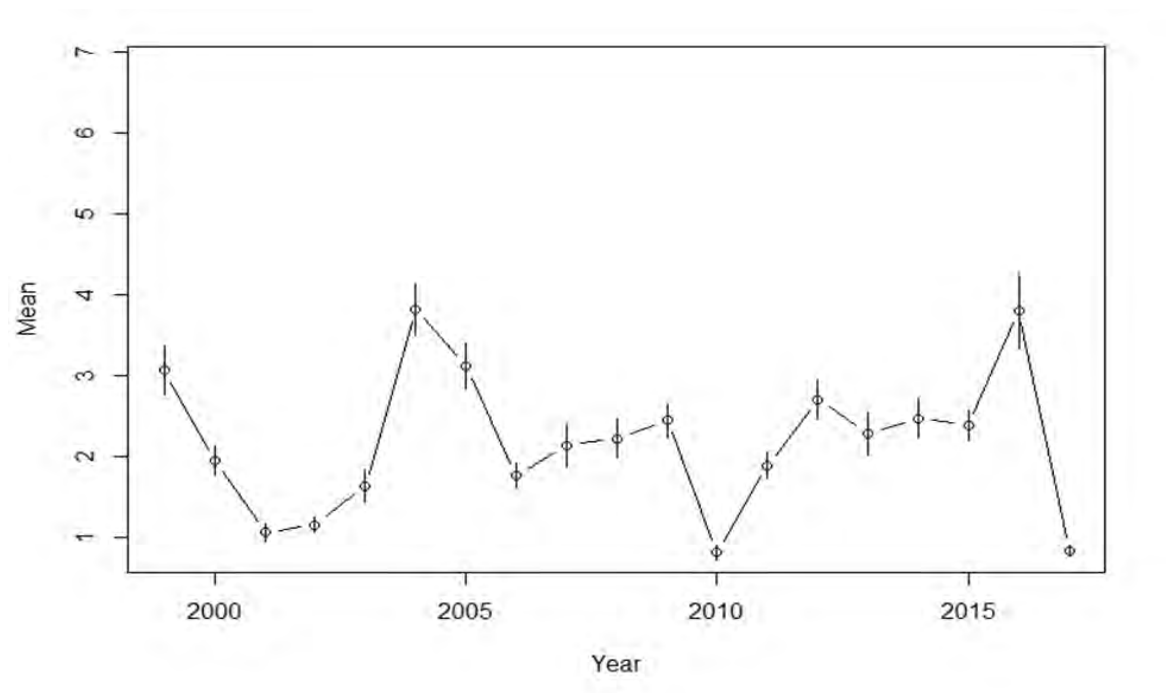
Figure 47. Abundance index for adult female horseshoe crabs (>= 19 cm pw) in the fall (October) from New Jersey’s Ocean Trawl Survey.